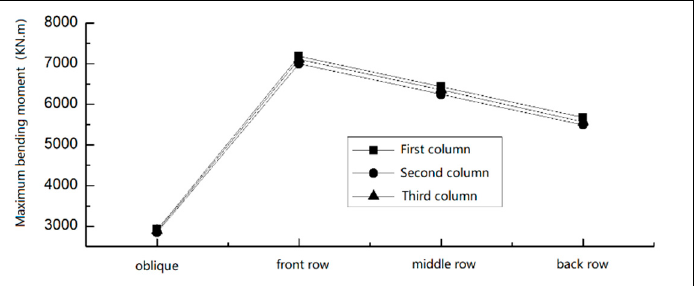
Figure 14. Maximum bending moment diagram of each pile